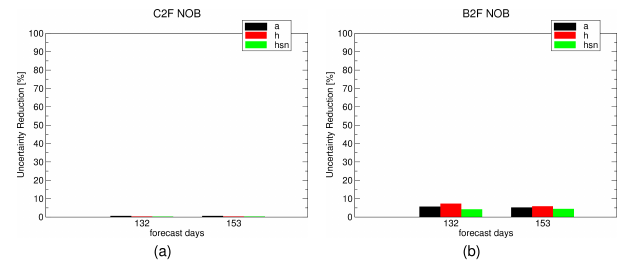
Figure9. UncertaintyreductionfortargetareasNOBforflighttransectC2F(panel a )andB2F(panel Figure 9. Uncertainty reduction for target areas NOB for flight tran- b ). sect C2F (panel a ) and B2F (panel b